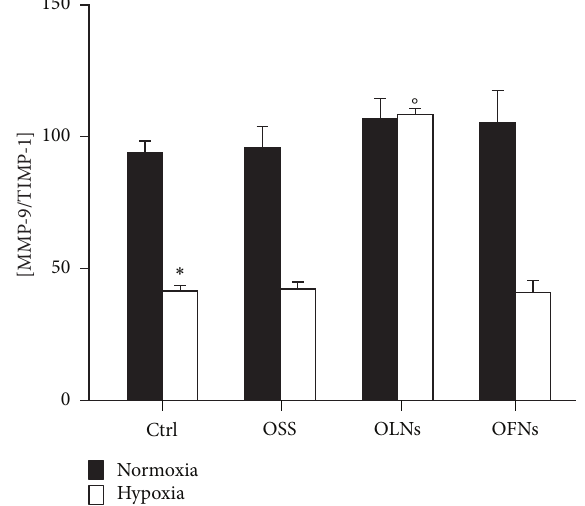
Figure 5: Hypoxia and OLN effects on MMP-9/TIMP-1 balances upon secretion by human monocytes. MMP-9/TIMP-1 stoichiomet- ric ratio was calculated after results from ELISA investigation (see Figures 3 and 4). Results are shown as means + SEM from three independent experiments. Data were also evaluated for significance by ANOVA: ∗ versus normoxic control cells: 𝑃 < 0.0001 ; ∘ versus hypoxic control cells: 𝑃 < 0.0001